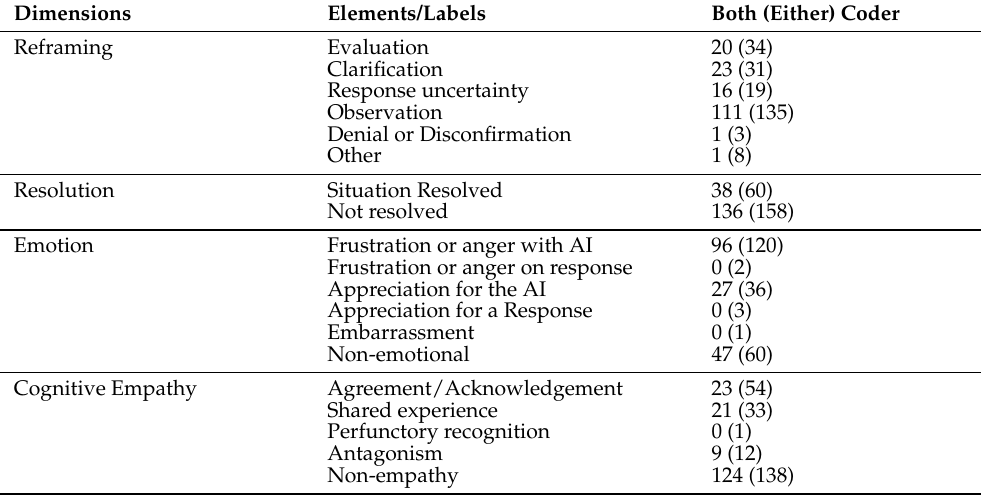
Table 3. Results of the communication coding for each dimension within each coding scheme. The counts shown are the numbers that both coders agreed on and the numbers that at least one coded for each